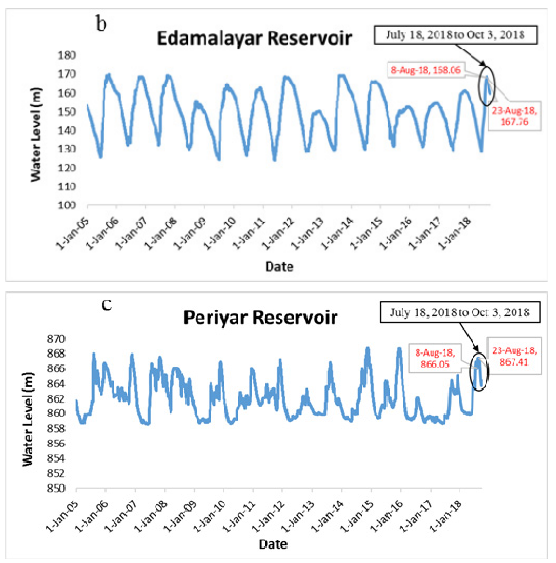
Figure 8 a). The variation of water level in Idukki reservoir from 2005-2018. The FRL of Idukki reservoir is 732.43 m. And, water level during Kerala flood 2018 as on Aug 8 and Aug 23 were 730.49 m and 731.69 m respectively. Figure 8 b). The variation of water level in Edamalayar reservoir from 2005-2018. The FRL of Edamalayar reservoir is 169.00 m. And, water level during Kerala flood 2018 as on Aug 8 and Aug 23 were 168.06 m and 167.76 m respectively. Figure 8 c). The variation of water level in Periyar reservoir from 2005-2018. The FRL of Periyar reservoir is 867.41 m. And, water level during Kerala flood 2018 as on Aug 8 and Aug 23 were 866.05 m and 867.41 m respectively.